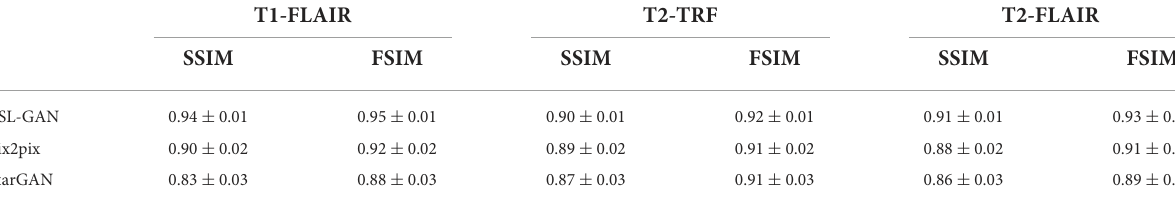
TABLE 3 SSIM and FSIM scores of the proposed method are compared with Pix2Pix and